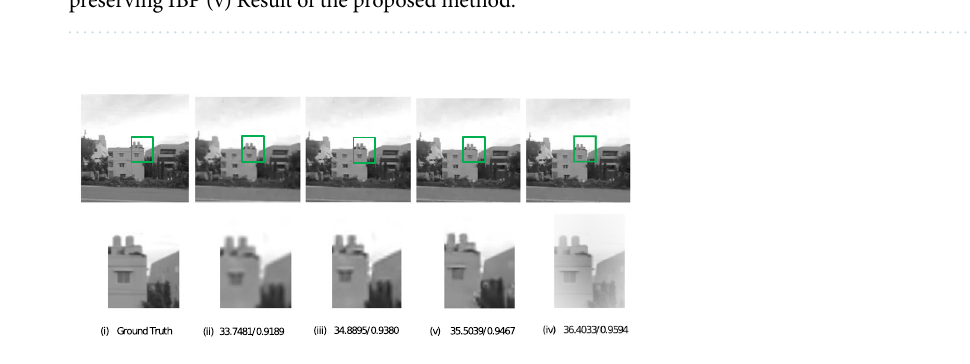
Figure 4. Result of enhancement on Building image with PSNR and SSIM values (i) Ground Truth (ii) Degraded low resolution Image (iii) Result of conventional IBP enhancement technique (iv) Result of Edge preserving IBP (v) Result of the proposed